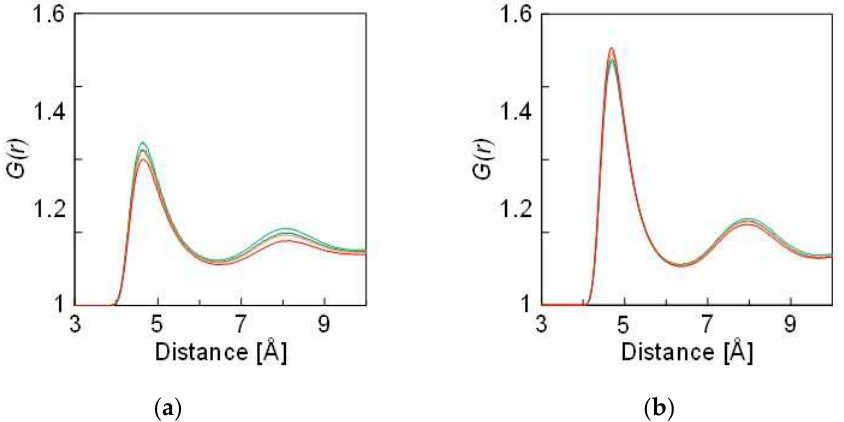
Figure 5. Radial distribution functions of Na with respect to S Ar. The ε value of the S Ar solute is as denoted in Table 1 in ( a ) and doubled in ( b ). The green, blue, orange, and red lines represent 3.0, 4.5, 5.9, and 9.1 wt.% of the solute concentrations, respectively.